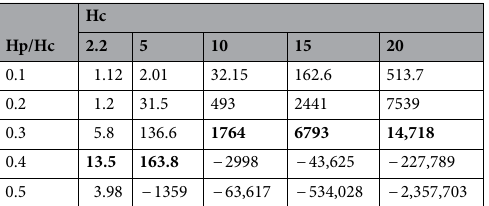
Table 4. Interaction effect of Hp and Hc. Significant values are in bold.